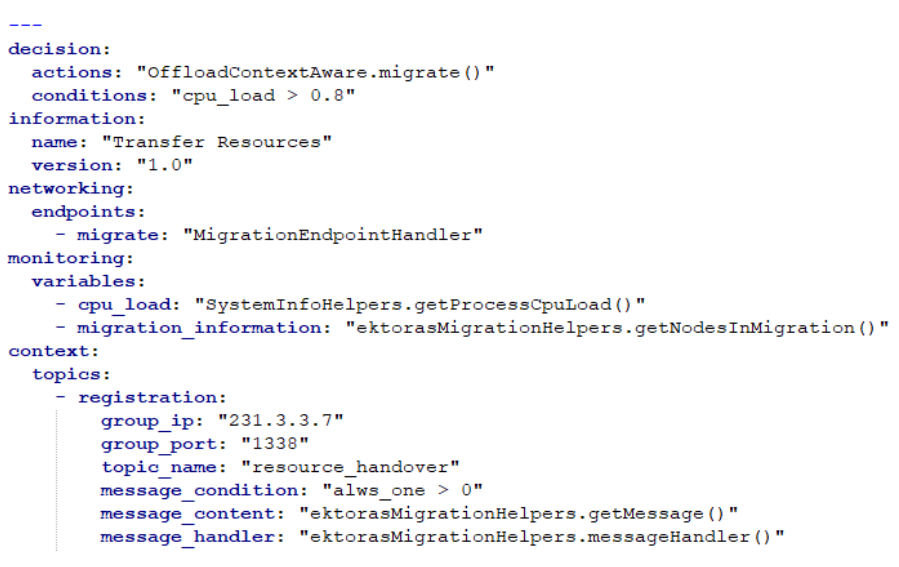
Figure 3. Example of deployed